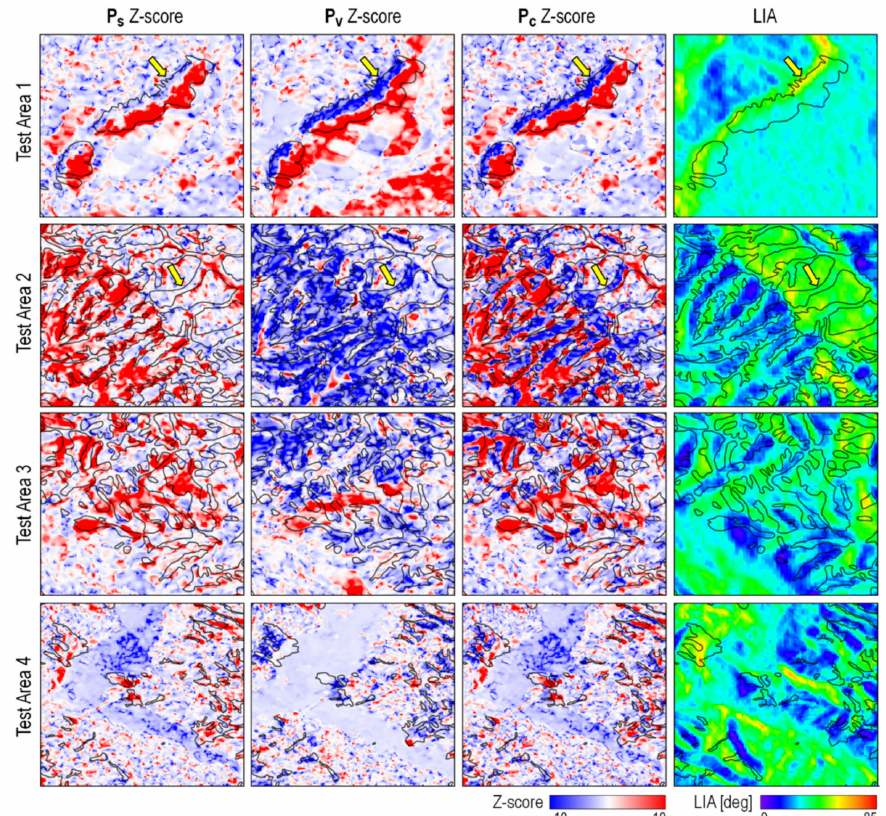
Figure 5. Comparison of Z-score maps generated from the odd-bounce surface scattering power ( P s ) and the diffused (volumetric) scattering power ( P v ), and the combined Z-score map ( P c Z- score). Yellow arrows indicate places with low Z-score amplitudes in P s but high amplitude in P v , a phenomenon associated with the local incidence angles (LIAs). Yellow arrows indicate landslide patches better depicted by combining the Z-score values from P s and P v